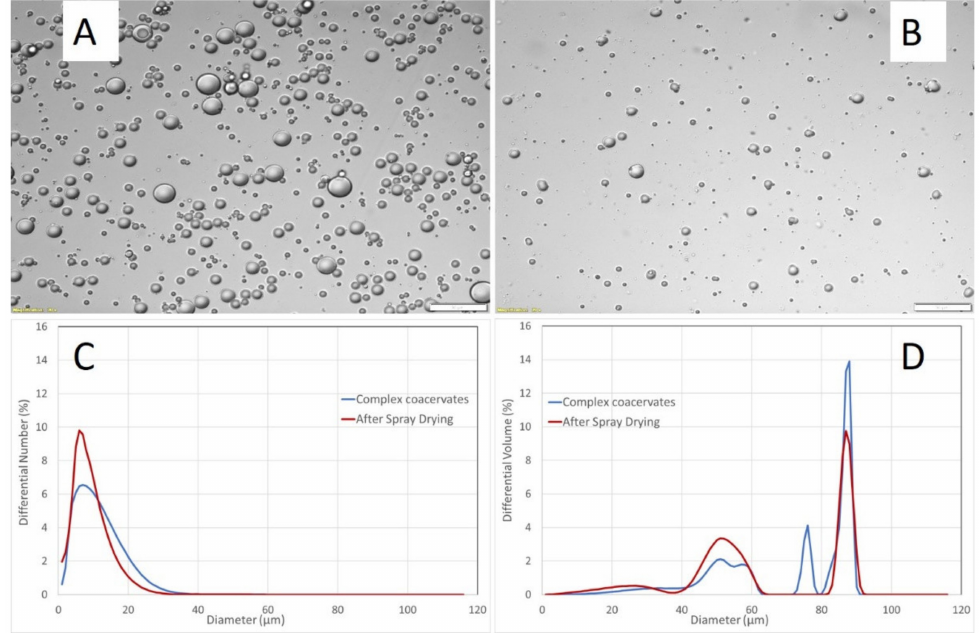
Figure 2. Optical microscopy images of peppermint oil complex coacervate microcapsules before ( A ) and after ( B ) spray drying, as well as their respective size distribution according to differential number ( C ) and differential volume ( D ). The scale bar corresponds to 50 µ m. Samples shown here: Polymer:Oil = 2:1 and crosslinker concentration = 5% ( w : w ) with respect to BSA.